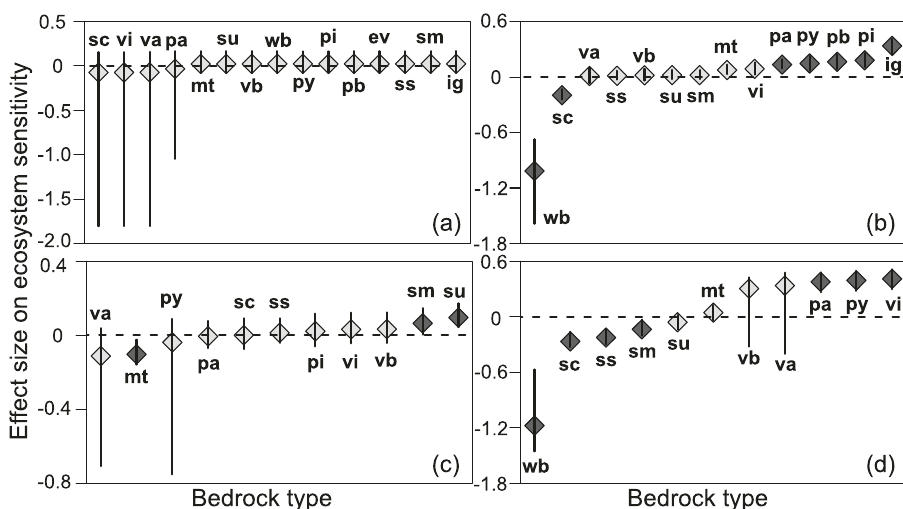
Fig. 5 Effect size of different types of bedrock lithology on ecosystem sensitivity in different regions. a Region I. Negative-sensitivity regions; b Region II. Energy-limited regions; c Region III. Humid tropical regions; and d Region IV. Hyper-arid regions of positive sensitivity. Statistically signi fi cant effects are in black and those not signi fi cant are in gray. Bedrock class: “ ev ” - evaporites, mt metamorphic rocks, “ pa ” - acid plutonic rocks, “ pb ” - basic plutonic rocks, “ pi ” - intermediate plutonic rocks, “ py ” - pyroclastics, “ sc ” - carbonate sedimentary rocks, “ sm ” - mixed sedimentary rocks, “ ss ” - siliciclastic sedimentary rocks, “ su ” - unconsolidated sediments, “ va ” - acid volcanic rocks, “ vb ” - basic volcanic rocks, “ vi ” - intermediate volcanic rocks, “ wb ” - water bodies. The number of bedrock types is different among regions because not all lithology categories exist in each region. Diamond symbols denote the posterior mean values and the vertical lines denote the 95% credible intervals of the estimated